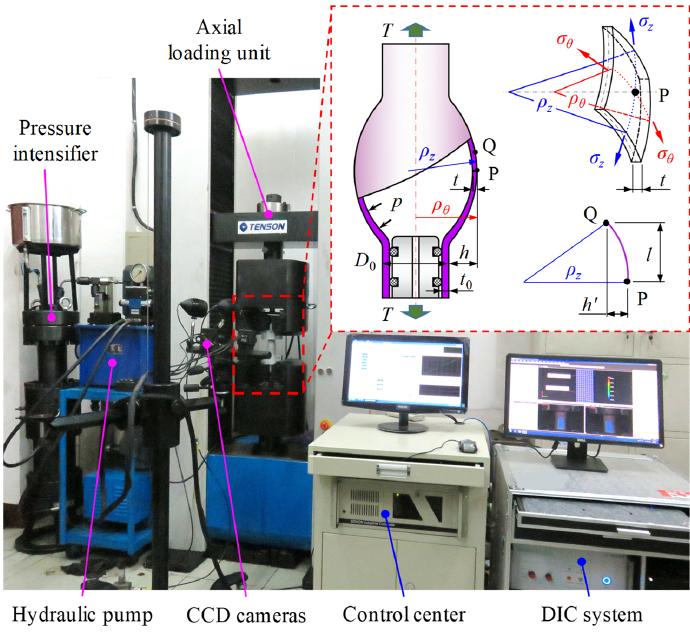
Figure 3. Principle and setup of tube controllable biaxial loading test.